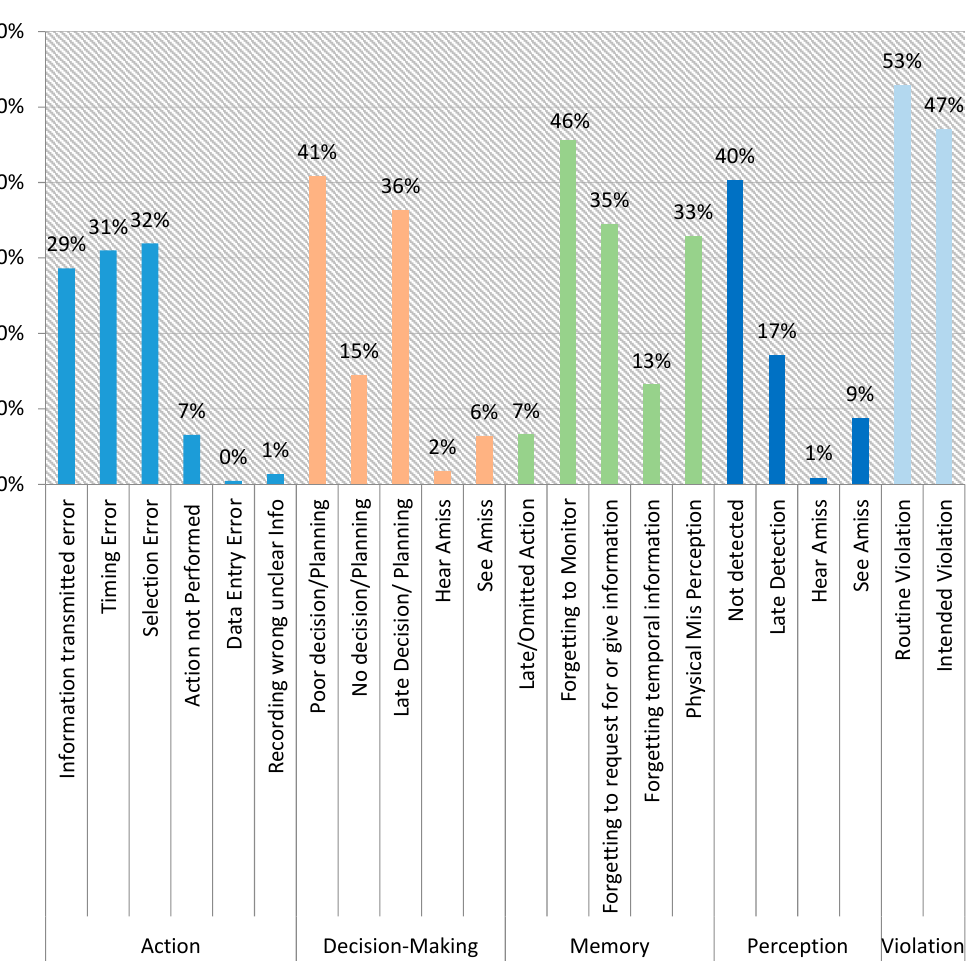
Figure 9. Percentages for Sub-levels of the Internal Error Mode (IEM).